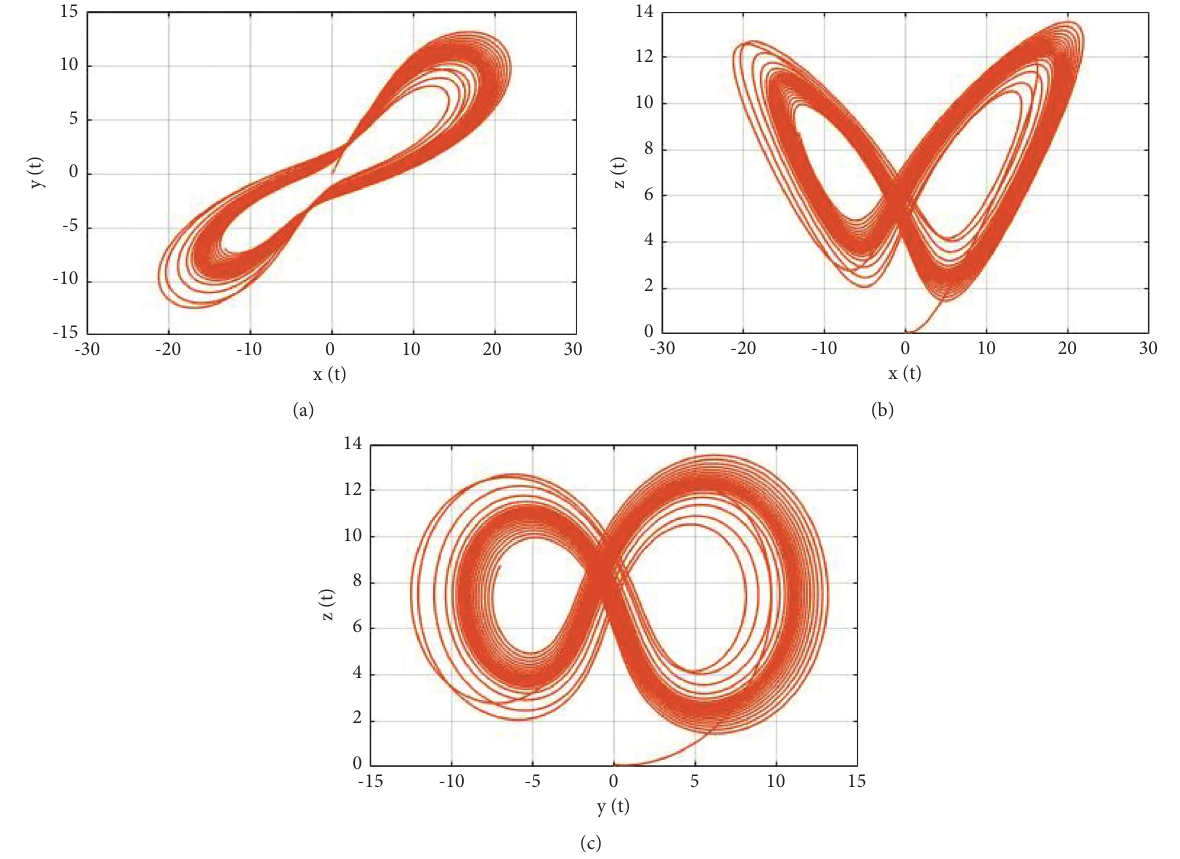
Figure 3: Phase portraits of system (25) for derivative order of q � 0.99 projected on different planes. (a) x - y plane. (b) x - z plane. (c) y - z plane.